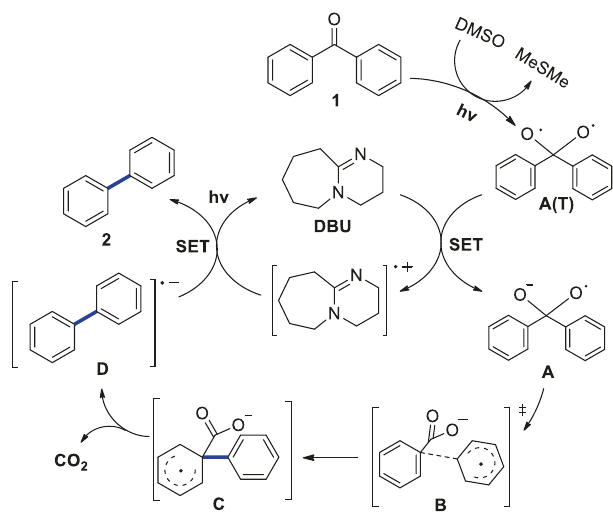
Fig. 6 Proposed mechanism. Possible reaction mechanism of decarbonylation of diaryl